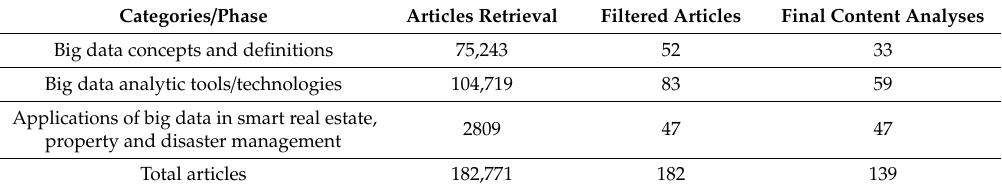
Table 2. Articles retrieved after each phase, as well as those filtered and shortlisted for final content